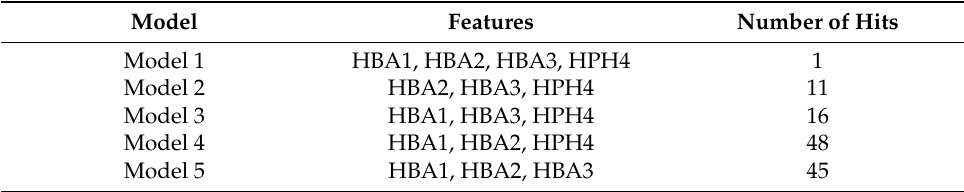
Figure 5. ( a ). Pharmacophore result for the four most active structures. Pharmacophore overlaid to digoxin ( b ). and salinomycin ( c ). Hydrogen Bond acceptors are presented in yellow and hydrophobic interactions in green. Table 3. DrugBank screening using different pharmacophore models.